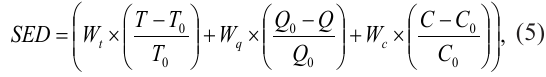
Fig. 2. Suggested expert system (dashed lines with three regions) and Abdolgawad-Fayek (AF) expert system (solid lines with five regions) for selection of response